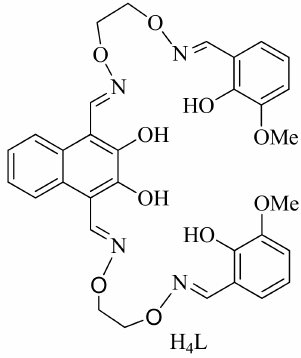
Figure 1. Structural representation of the ligand H 4 L.